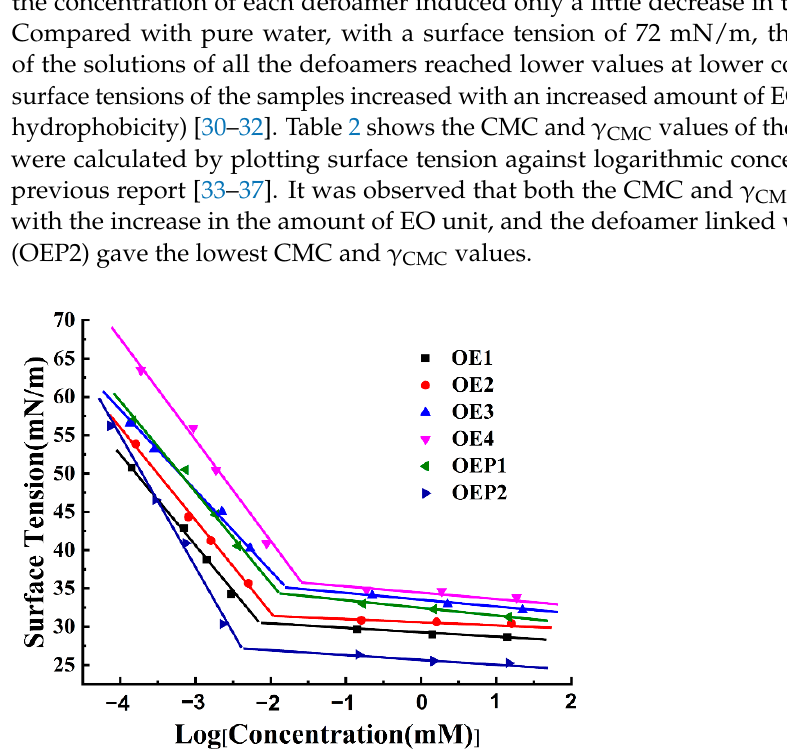
Figure 3. 1 H-NMR spectra of the prepared defoamers.